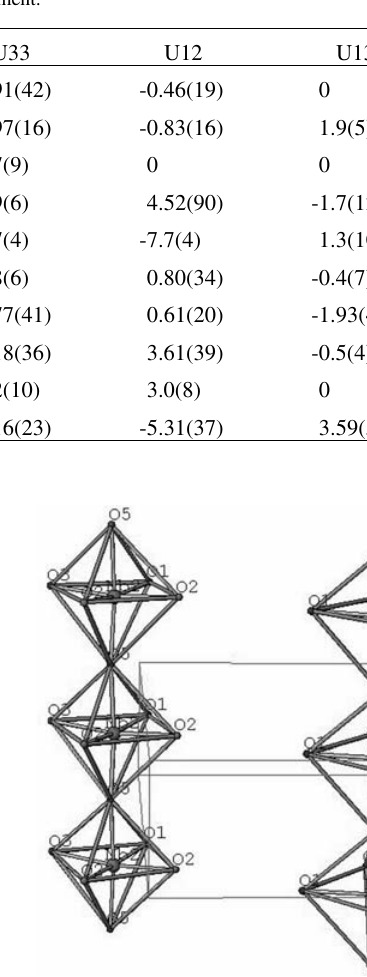
Figure 4. The displacement of Nb cation from the planes formed by oxygen is